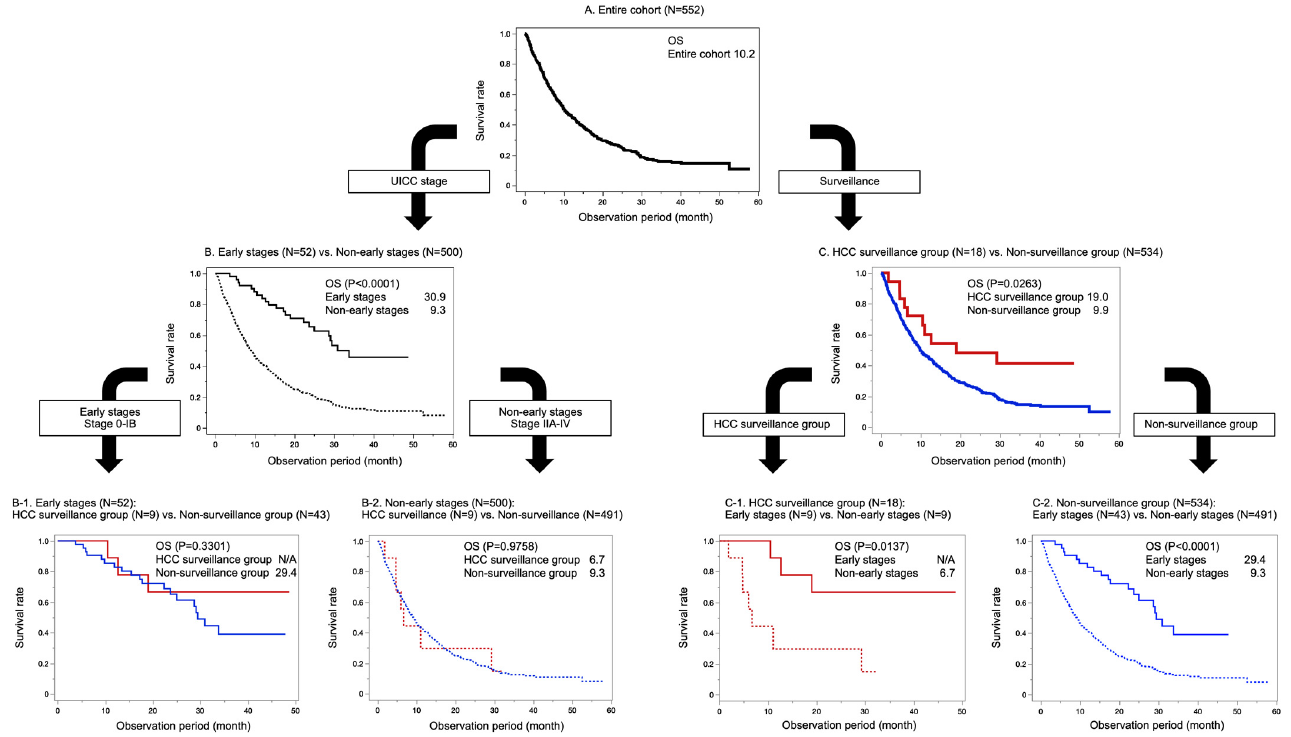
Figure 1. Long-term outcomes of pancreatic cancer patients ( A ). Comparison between the stages ( B ) and their corresponding surveillance groups ( B1 , B2 ). Comparison between the surveillance groups ( C ) and their corresponding stages ( C1 , C2 ). The lines represent the following: entire cohort (black bold), early stages (black solid), non-early stages (black dot), HCC surveillance group (red bold), non-surveillance group (blue bold), early stages/HCC surveillance group (red solid), early stages/non-surveillance group (blue solid), non-early stages/HCC surveillance group (red dot), and non-early stages/non-surveillance group (blue dot). OS, overall survival; UICC, Union for International Cancer Control; HCC, hepatocellular carcinoma.